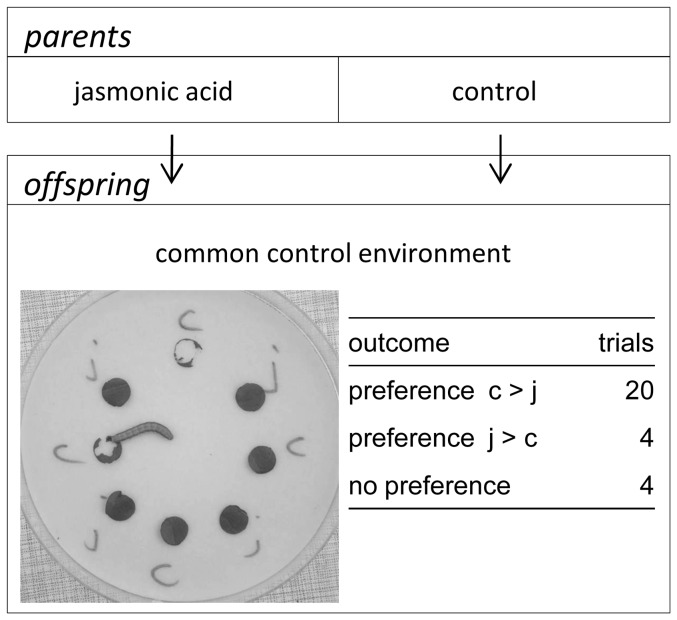
Experiment 1: design and results of Spodoptera exigua choice feeding assays.Inset picture: J, offspring of JA-treated plant; C, offspring of control plant. Inset table shows for each independent trial if more tissue was consumed from JA-offspring or from control-offspring leaf discs.